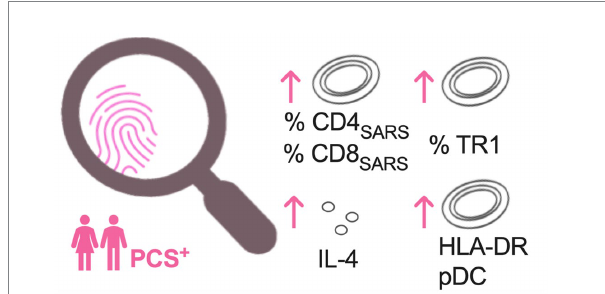
FIGURE 3 Most pronounced immune alterations in PCS patients at week 6 and month 7 after symptom onset. Increased frequencies of protein-S1- stimulated SARS-CoV-2 specific CD4 + (CD4 SARS ) and CD8 + T-cells (CD8 SARS ), type 1 regulatory T cells (TR1), levels of interleukin 4 (IL-4), and HLA-DR expression on plasmacytoid dendritic cells (pDC) in PCS patients when compared to convalescents without PCS and controls. PCS, post-COVID syndrome; PCS + , PCS patients; and HLA- DR, human leukocyte antigen